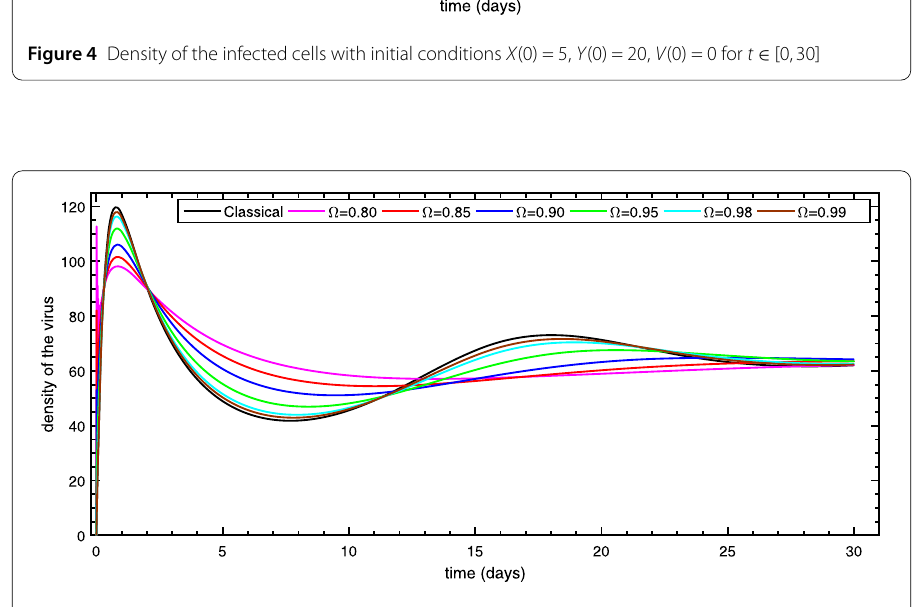
Figure 5 Density of the virus X (0) = 1, Y (0) = 10, V (0) = 0 for t ∈